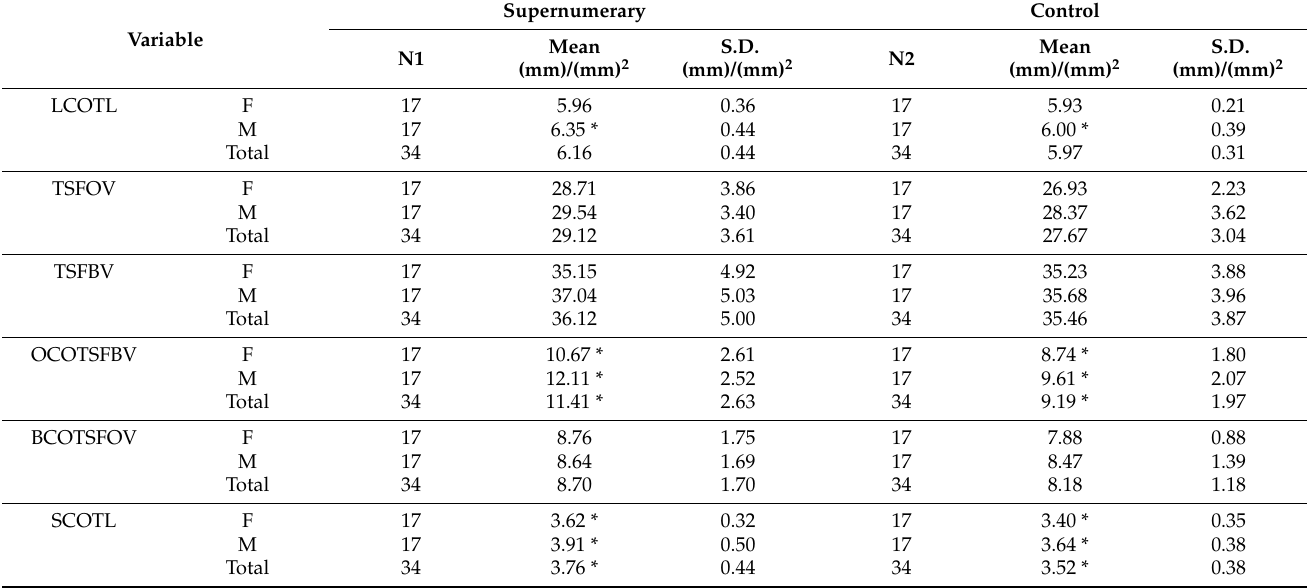
Table 6. Variables of mandibular lateral incisors of supernumerary and control